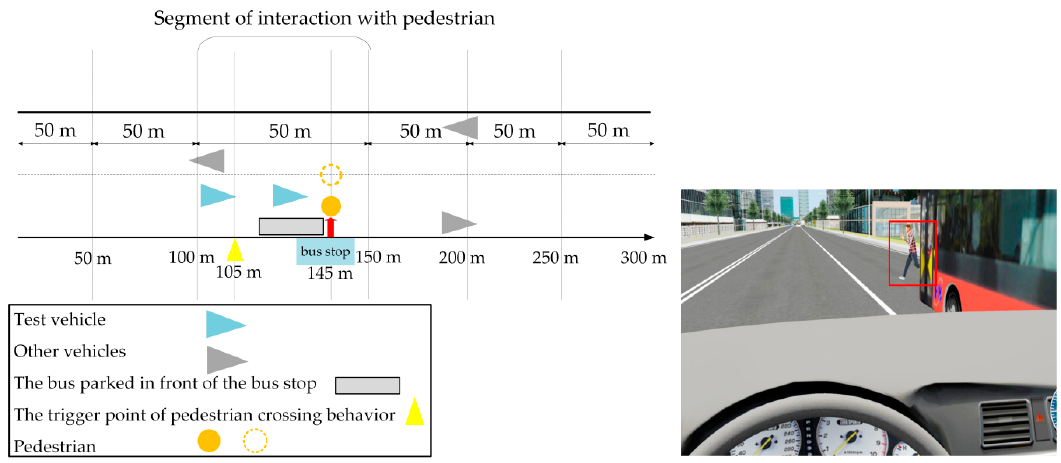
Figure 4. Schematic diagram of high-risk scenario.